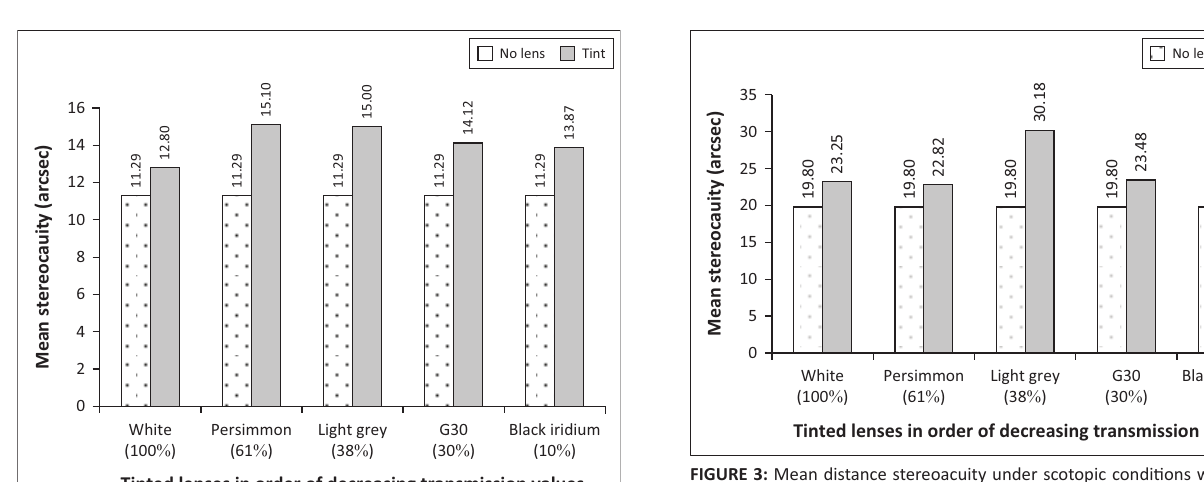
FIGURE 3: Mean distance stereoacuity under scotopic conditions with no lens versus tinted